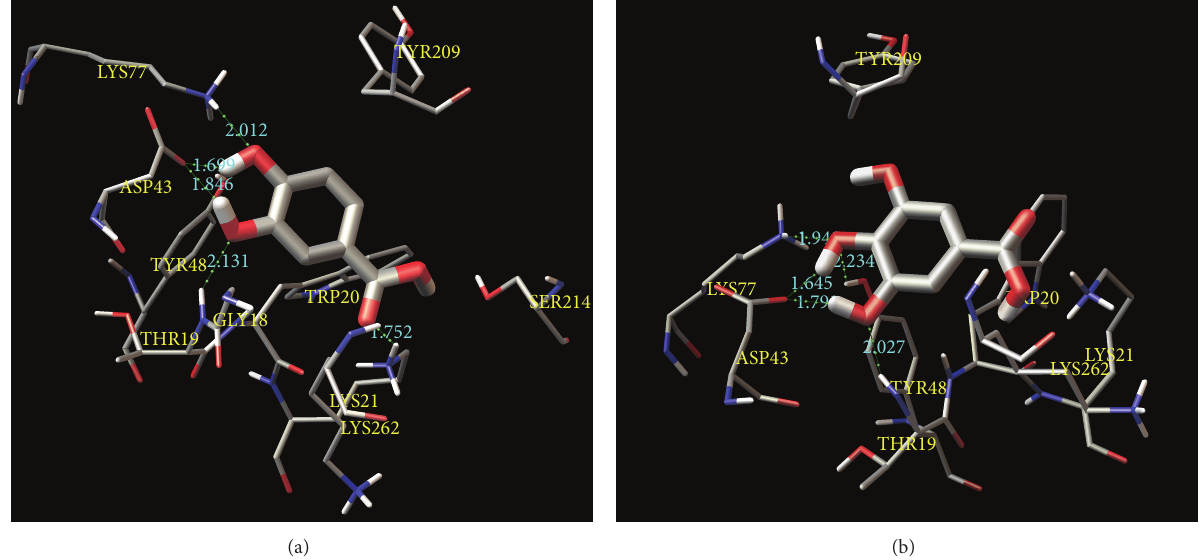
Figure 4: Interaction analysis of hydroxybenzoic acid derivatives docked with ALR2. Binding pose of protocatechuic acid (a) and gallic acid (b). The amino acid residues (in 1 ˚A distance) were represented in atom types and the hydrogen bonds were denoted in green spheres along with the